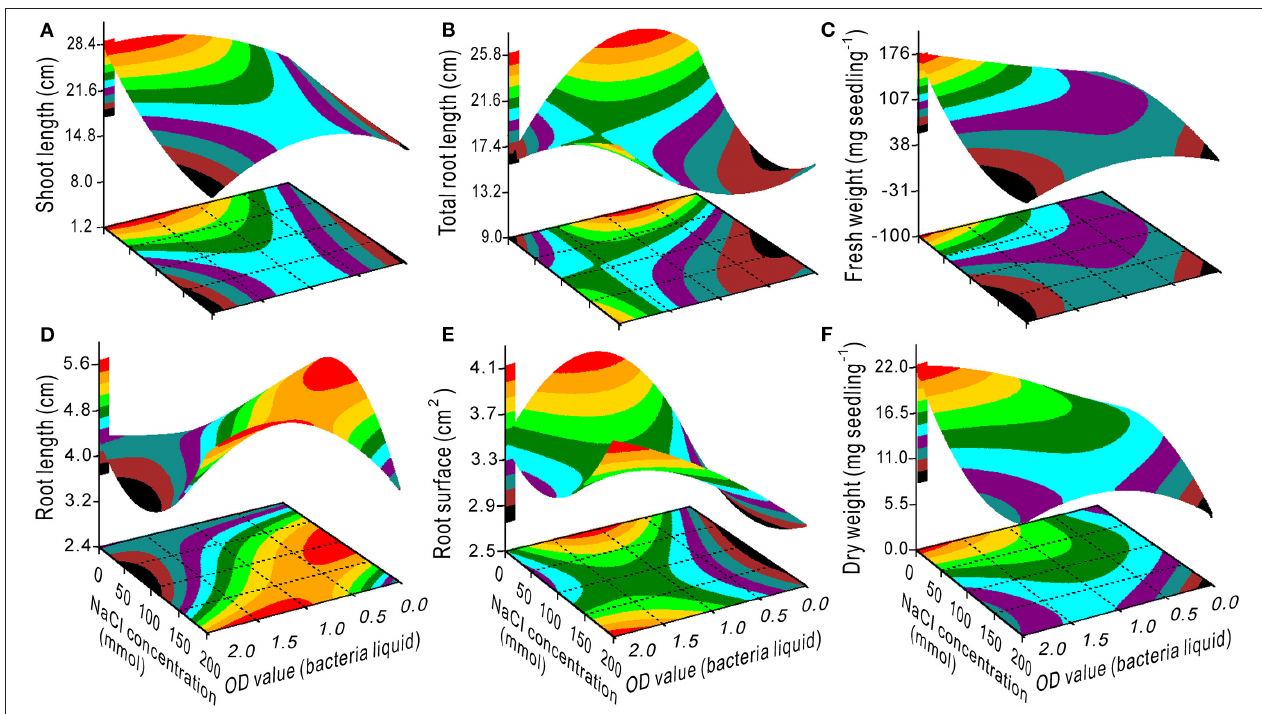
FIGURE 2 | Response surface plots showing the interaction between the NaCl concentration and bacterial liquid on shoot length (A) , total root length (B) , fresh weight (C) , root length (D) , root surface (E) , and dry weight (F) .